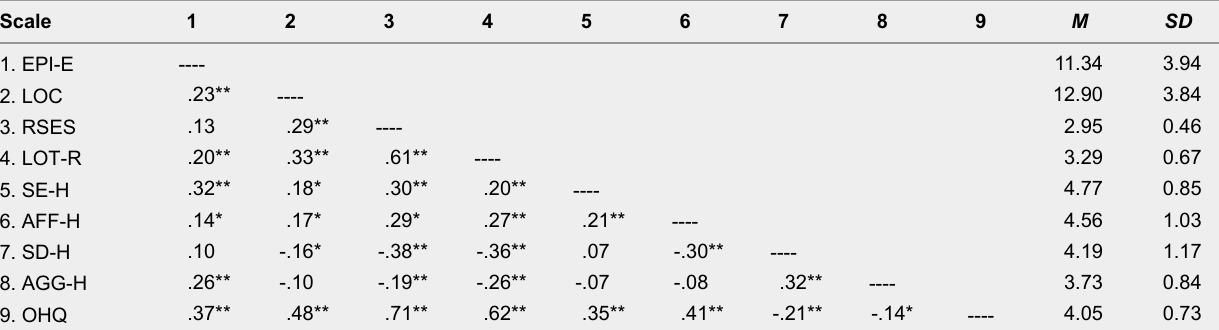
Correlations and Descriptive Statistics for Measures of the Four Happy Personality Traits, Measures of the Four Humor Styles and Scores on the